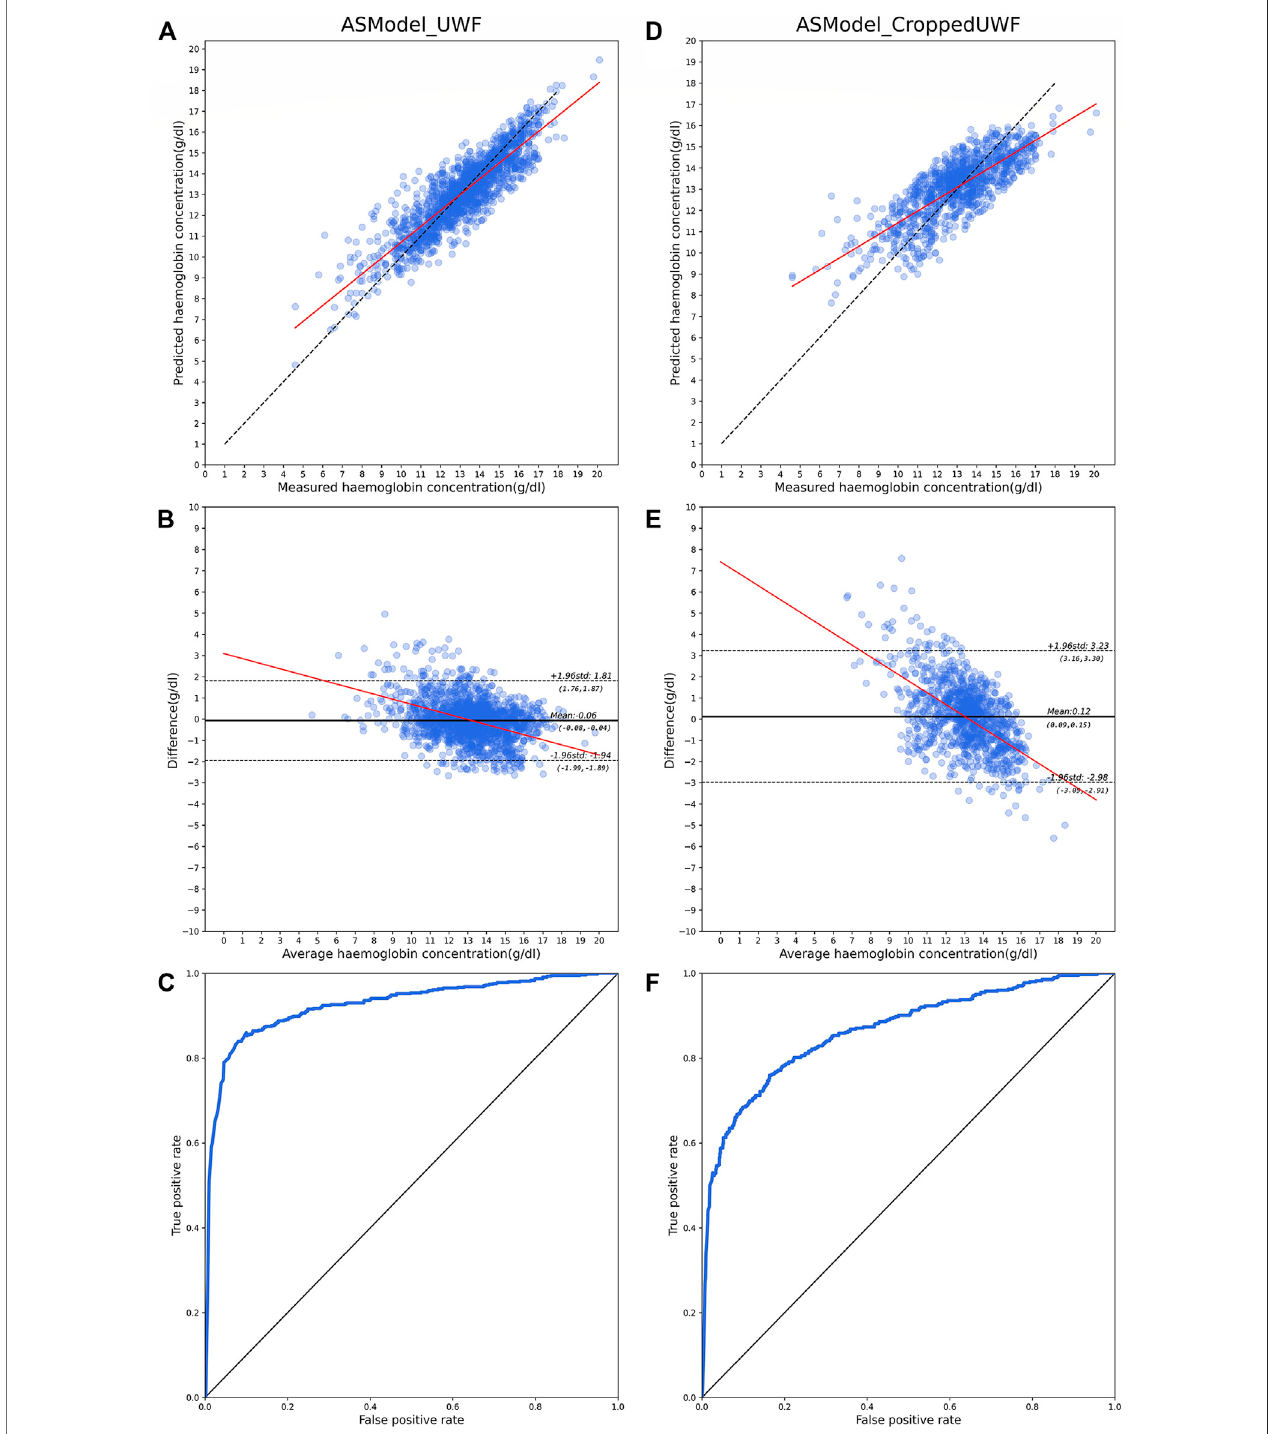
FIGURE 4 | Model performance for hemoglobin concentration prediction and anemia screening with UWF fundus images and cropped images. (A – C) are the resultsforASModel_UWF,while (D – F) aretheresultsforASModel_CroppedUWF. (A,D) Scatterdiagramsforhemoglobinconcentrationprediction.Eachdotrepresents the predicted value against the measured value, and the black broken line represents the ideal model, and the red line represents the linear fi t of results. (B,E) Bland – Altman plots for predicted and measured hemoglobin concentration. Each dot represents the difference predicted value and measured value against the measuredvalue.Theblacklinerepresents themeanvalueofthedifference, theblackbrokenlinesrepresent95%limitsofagreement,and theredlinerepresents theline fi t. (C,F) ROC curves for anemia screening.